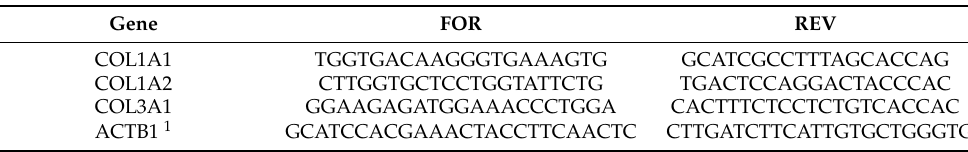
Table 1. Primer sequences for